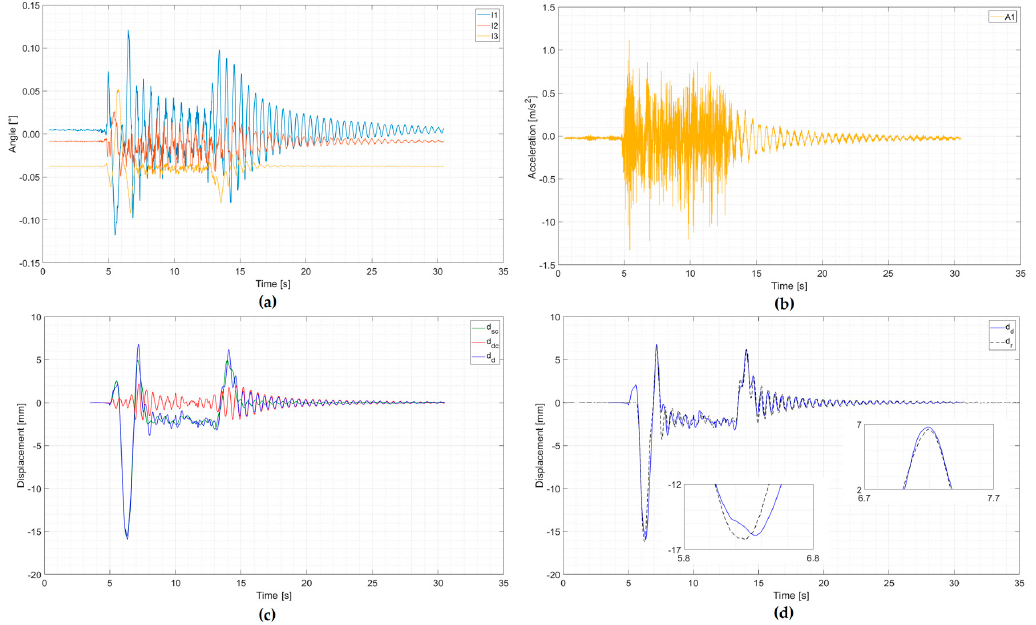
Figure 13. An example of an analysis of a separate locomotive and passenger cars passage with a speed of about 138 km / h: ( a ) Signals from inclinometers; ( b ) signal from an accelerometer; ( c ) determined quasi-static displacement component (from inclinometers) d sc , dynamic displacement component (from an accelerometer) d dc, and total dynamic displacement d d ; ( d ) comparison of total dynamic displacement d d with reference measurement d r (zoom of max and min